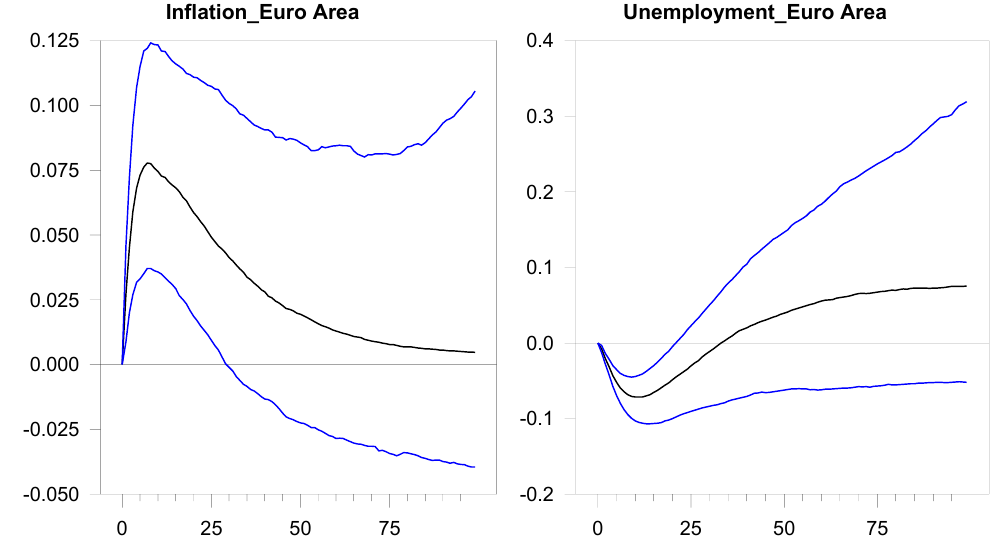
Figure 1. Responses of Euro Area inflation and unemployment to a contractionary monetary policy shock. Monetary policy shock identified as exogenous innovation to European Overnight Average Interest Rate (EONIA). Error bands set at the 10th and the 90th percentiles. Trivariate VAR model including inflation, unemployment and EONIA.